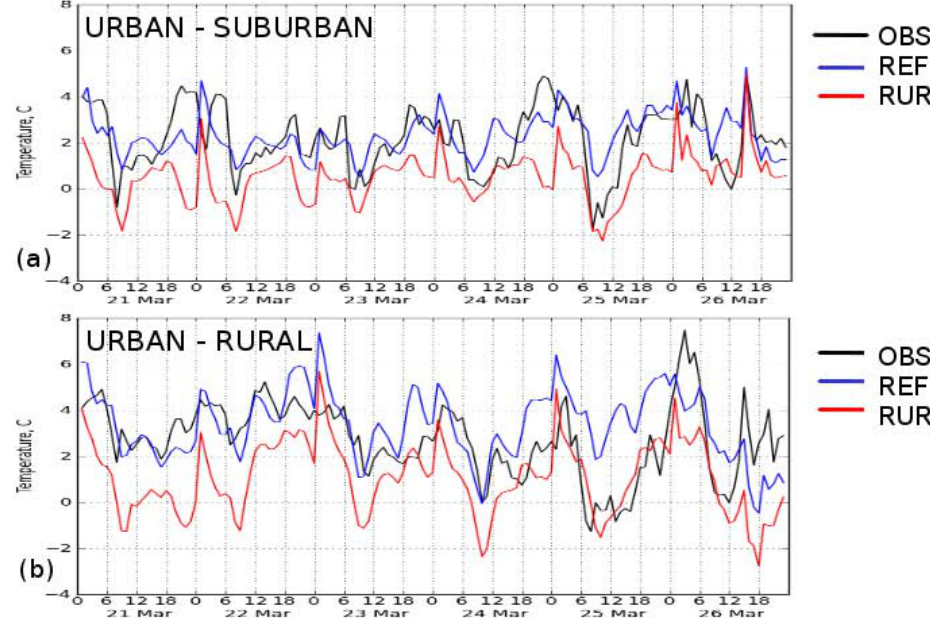
Fig. 5. Diurnal variation of hourly differences of temperature at 2m (in ◦ C) between urban and suburban stations (a) and between urban and rural stations (b) from observations (in black), REF (in blue) and RUR (in red) simulations.